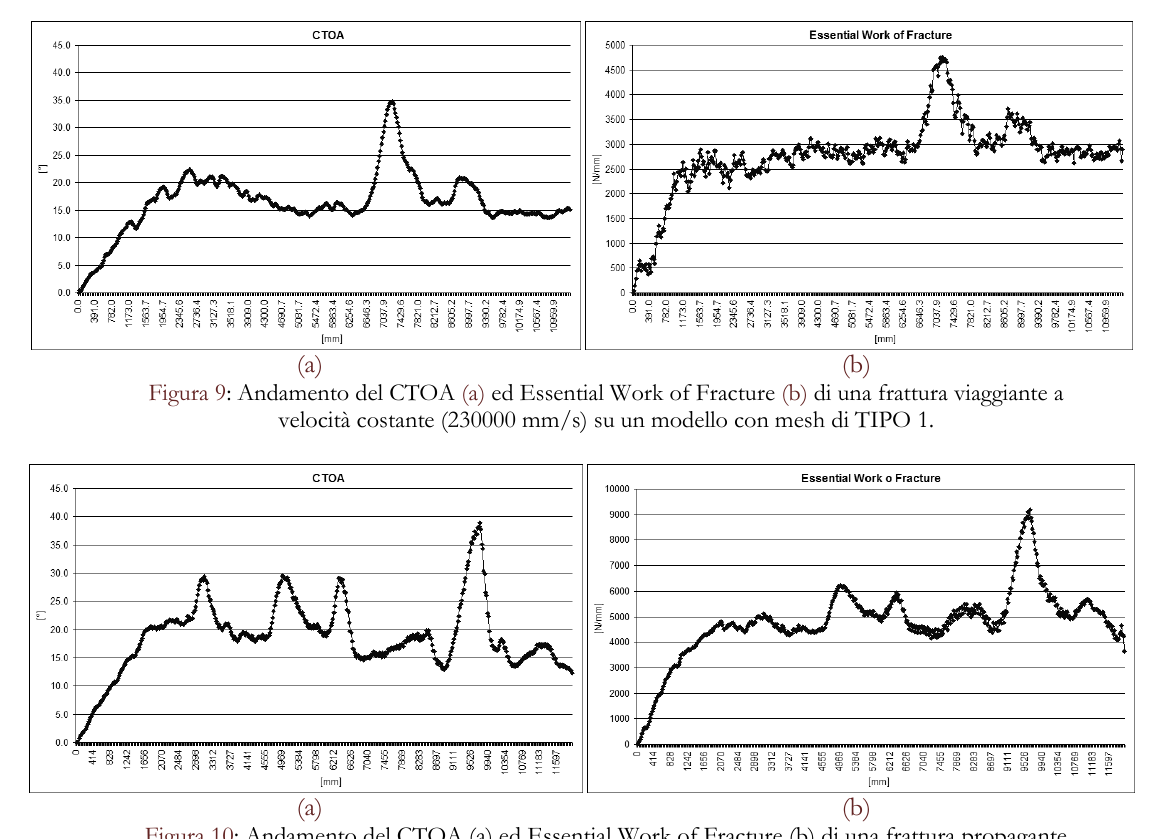
Figura 10: Andamento del CTOA (a) ed Essential Work of Fracture (b) di una frattura